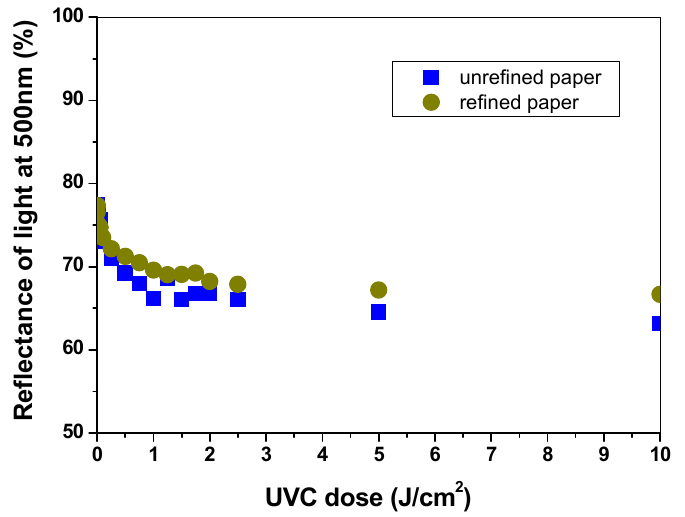
Figure 4. Comparison of the dose response for refined and unrefined paper samples with 20% PAN– PDA fibre dopant made of refined and unrefined cellulose pulp.